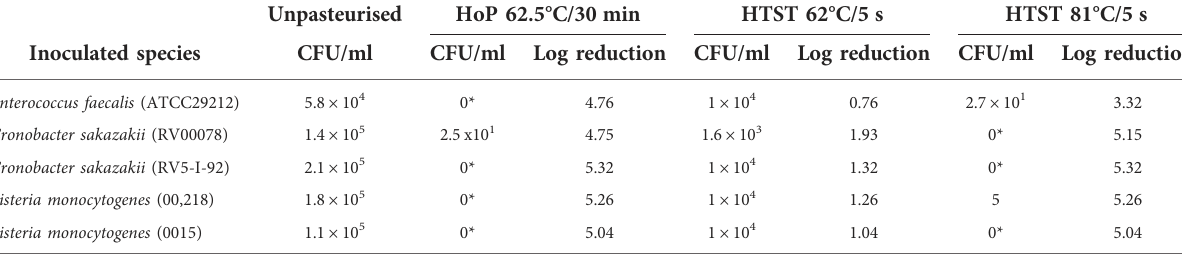
TABLE 1 Bacterial concentrations before and after heat treatment.